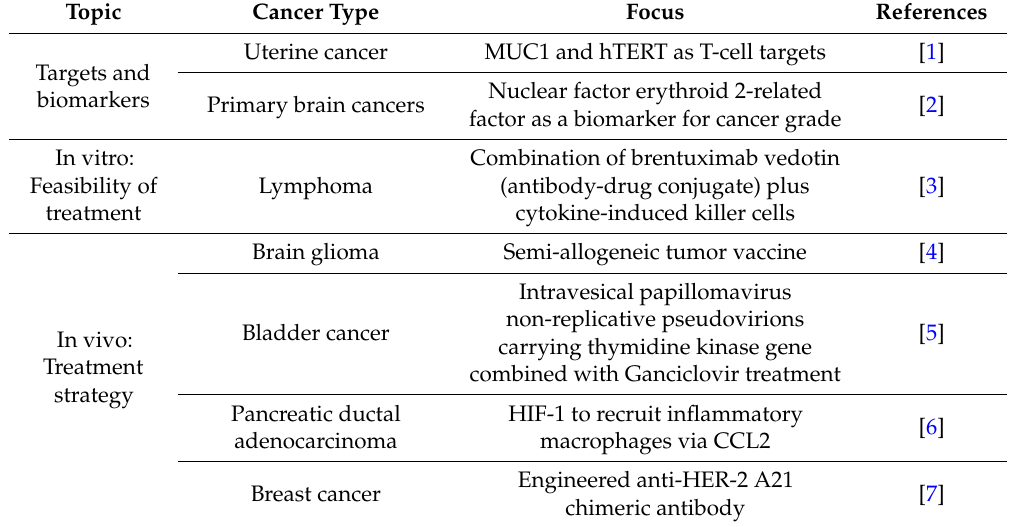
Table 1. Summary of original research articles in Special Issue “Cancer Immunology with a Focus on Understudied Cancers as Targets for Immunotherapy”.